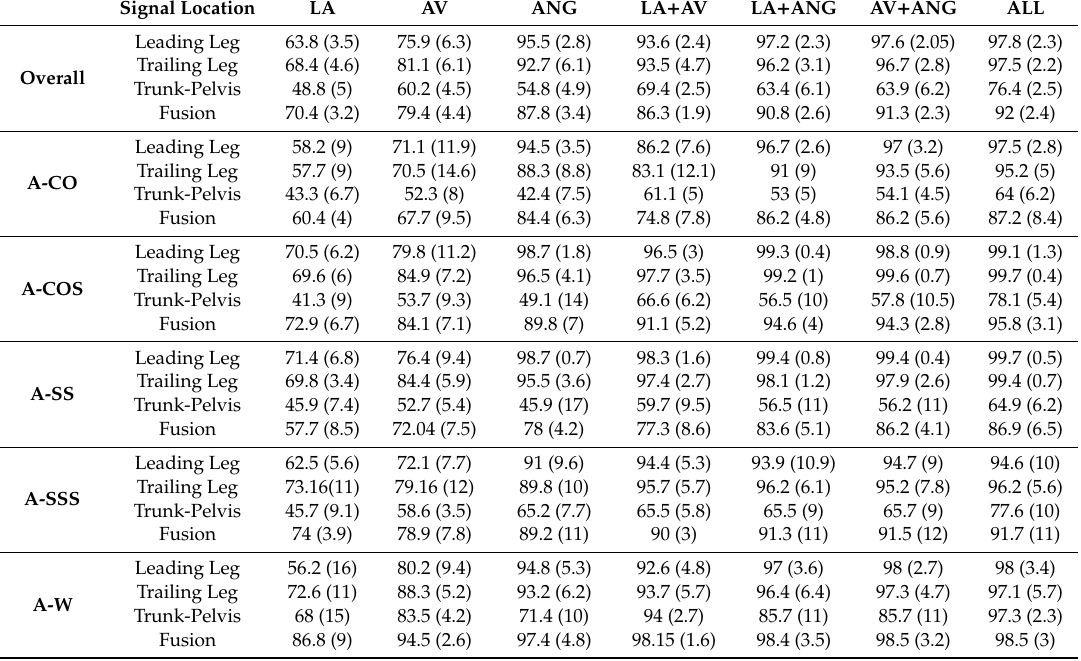
Figure 2. Classification accuracy of anticipated straight walking (A-W), crossover and sidestep cuts (A-CO, A-SS), cuts to stair ascent (A-COS, A-SSS), as well as overall accuracy across transitions using signals of varying modalities (LA, AV, ANG, LA + AV, LA + ANG, AV + ANG, ALL) and locations (the leading leg, trailing leg, trunk–pelvis, and fusion across locations). Asterisks denote modalities that were statistically different from signal combinations (alpha = 0.05). Table 1. Classification accuracy of anticipated locomotion modes (A-CO, A-COS, A-SS, A-SSS, A-W), as well as overall accuracy across transitions using signals of varying modalities and locations. Values represent the mean (standard deviation).